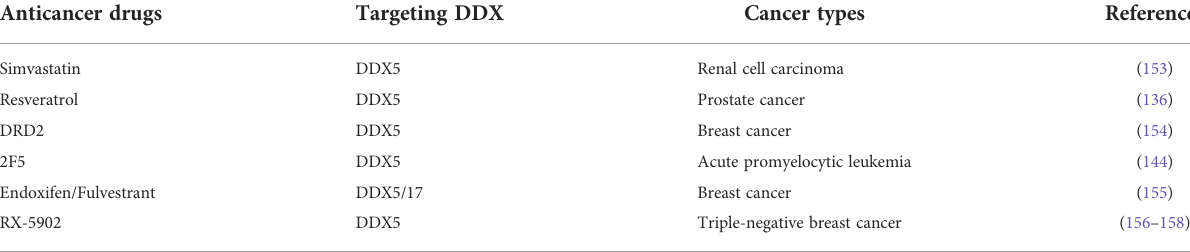
TABLE 3 Anticancer drugs target DDX5/17 to inhibit tumor progression. Anticancer